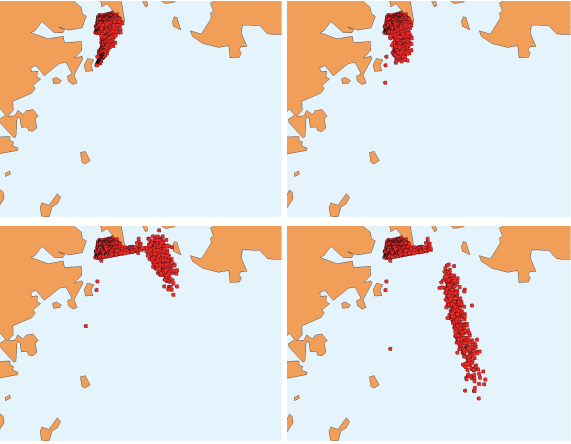
Fig. 7. First 24h of the OD3D simulation with Skagerrak 1.5km forcing (i.e. the oil 6, 12, 18, and 24h after the accident). The red dots represent oil particles. The particles left behind very close to the land mask represent beached